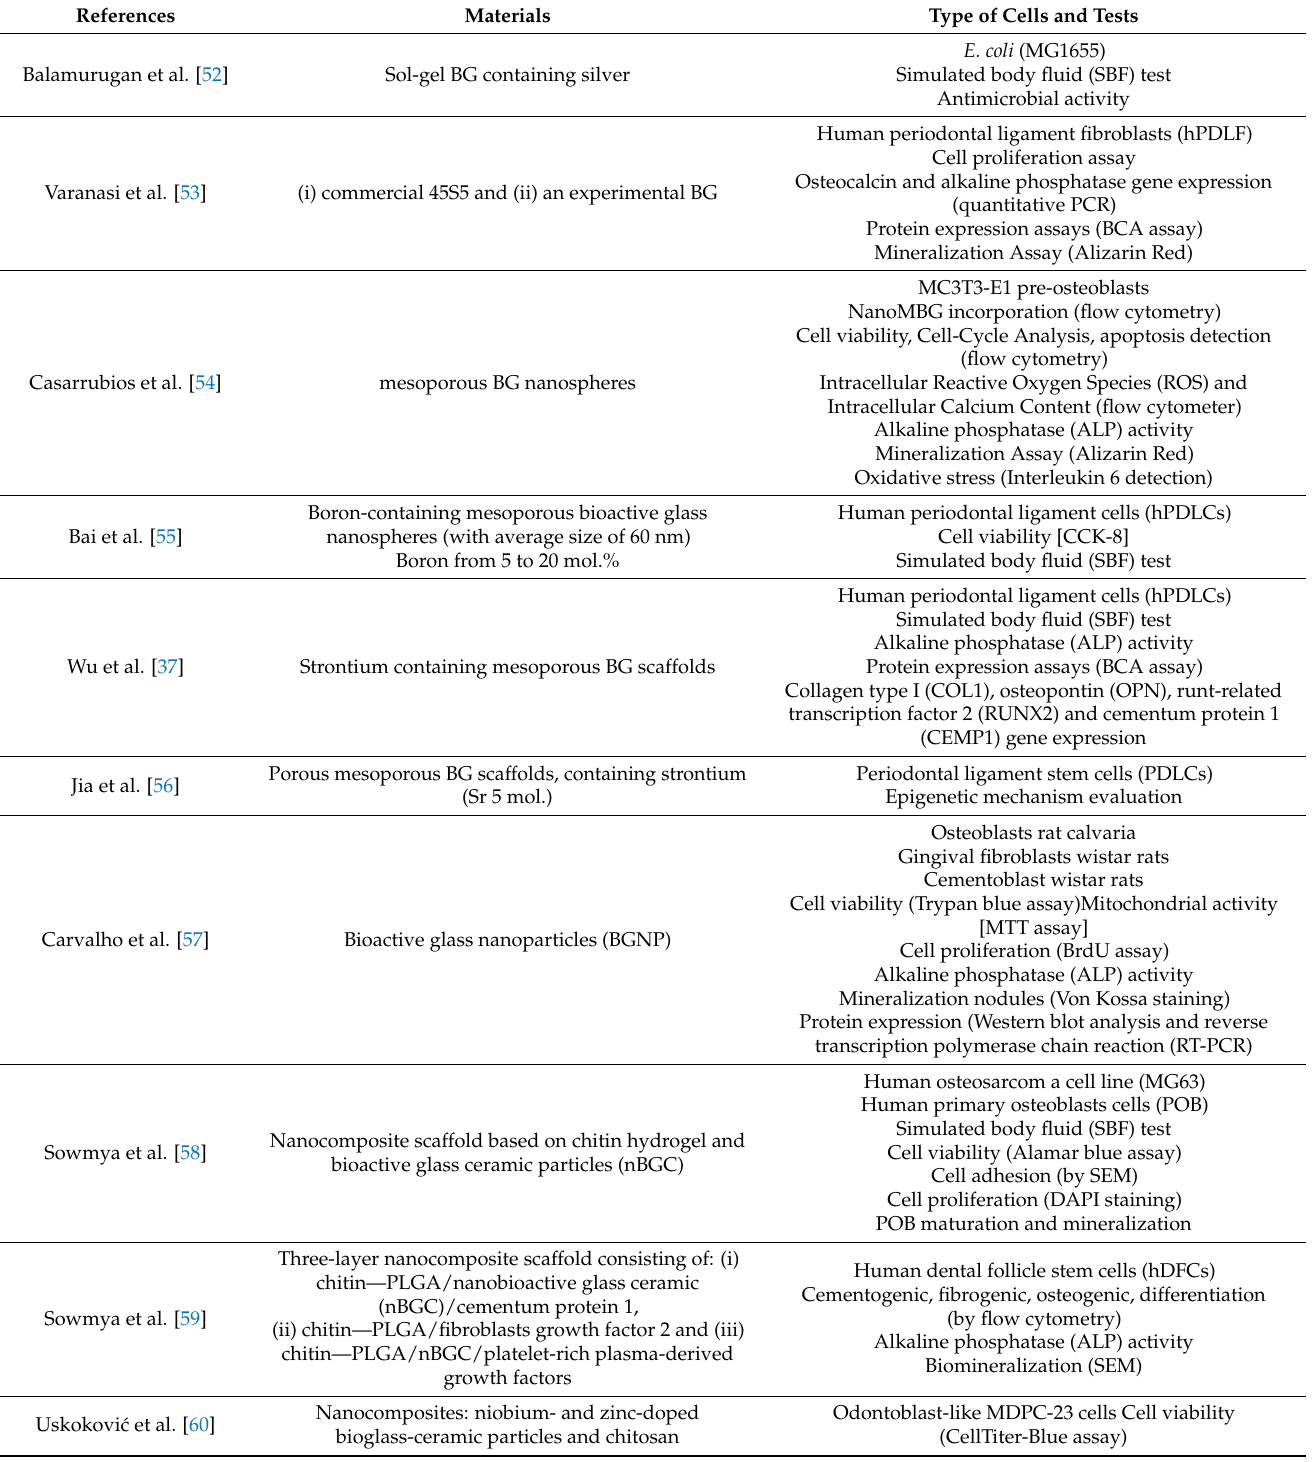
Table 1. Summary of in vitro